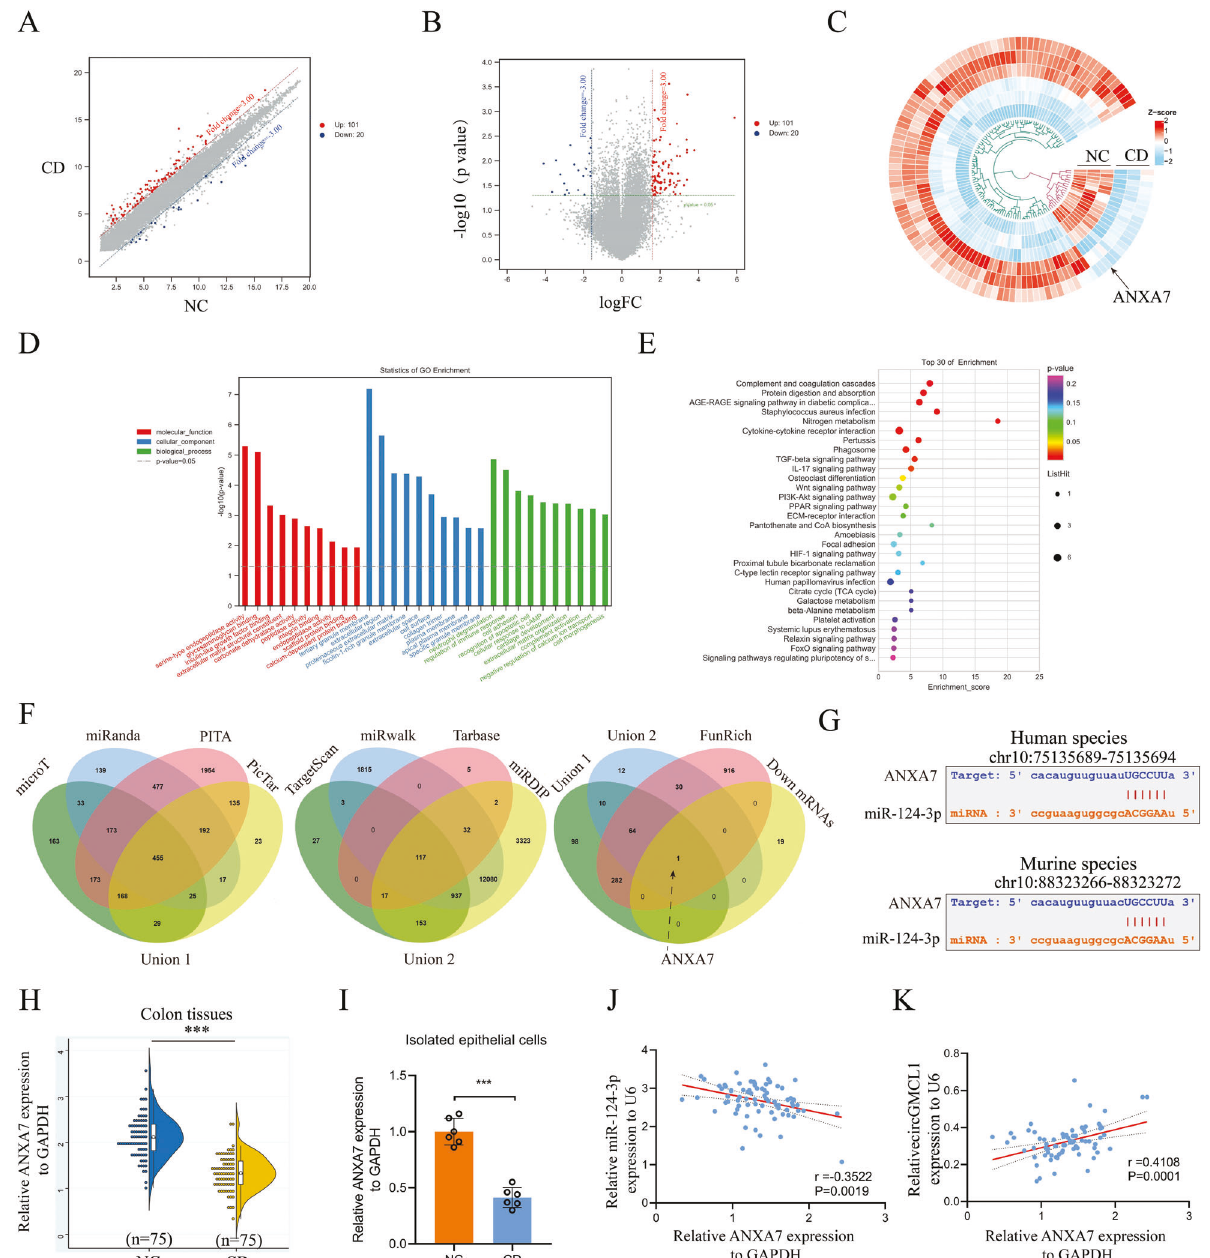
Fig. 3 ANXA7 was identi fi ed as one target gene of miR-124-3p. Scatter plots ( A ), volcano plots ( B ), and heatmap ( C ) showing mRNA expression pro fi le of colon tissues from CD patients and NCs (threshold: FC > 3, P < 0.05). The histogram ( D ) and bubble ( E ) displaying results of Go enrichment analyses, including BP, MF, and CC for the dysregulated mRNAs. Relative circGMCL1 expression in colon tissues from CD patients and NCs as determined by qRT-PCR analysis. F Venn diagram displaying the overlapping miR-124-3p target predicting algorithms and up-regulated mRNAs. G The predicted binding sites between miR-124-3p and ANXA7 in human and mouse species based on starbase database. Relative ANXA7 expression in colon tissues H and isolated epithelial cells I of CD patients and NCs as determined using qRT-PCR assay. The linear correlation between relative ANXA7 expression and miR-124-3p J , circGMCL1 K in CD patients ( n = 75) as evaluated by qRT- PCR analysis. ANXA7 annexin 7, CD Crohn ’ s disease, NC normal control, FC fold change, GO gene ontology, BP biological processes, MF molecular function, CC cellular component, qRT-PCR quantitative real time-polymerase chain reaction. Data are presented as mean ± SD. *** P < 0.001 by Student ’ s t